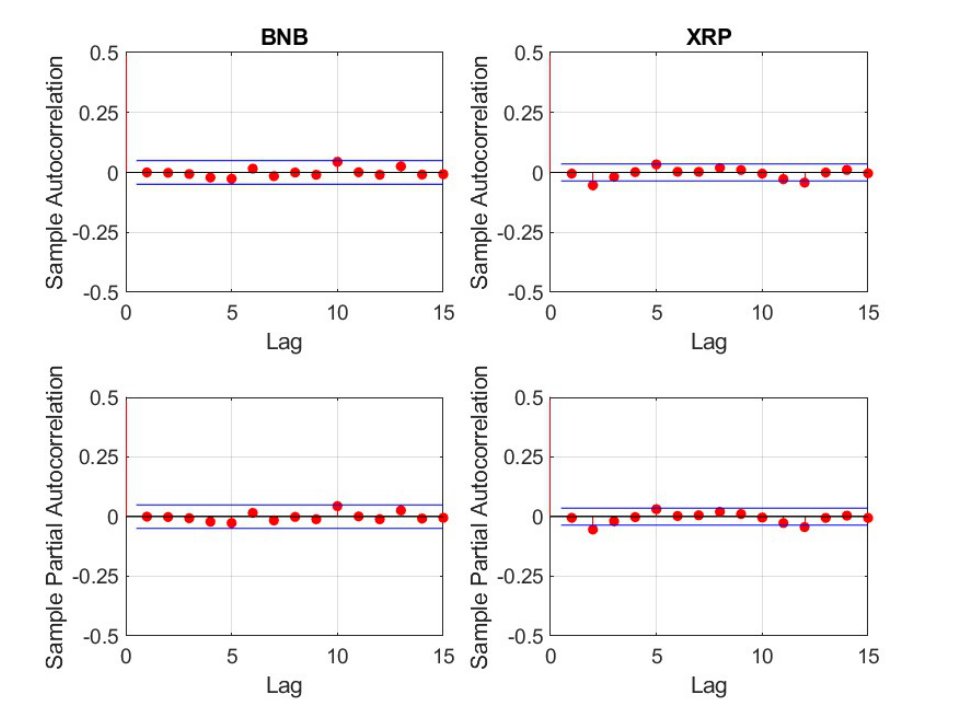
Figure A9. BNB’s and XRP’s residuals’